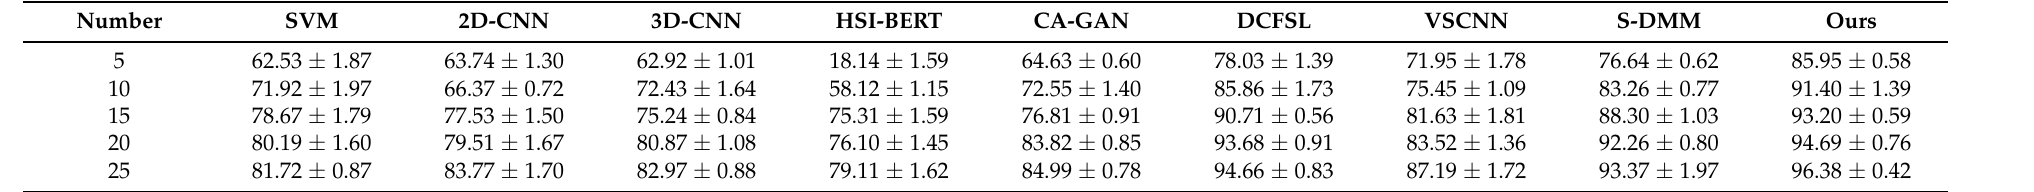
Table 9. The classification results of our proposed and other leading methods on Pavia University (%).